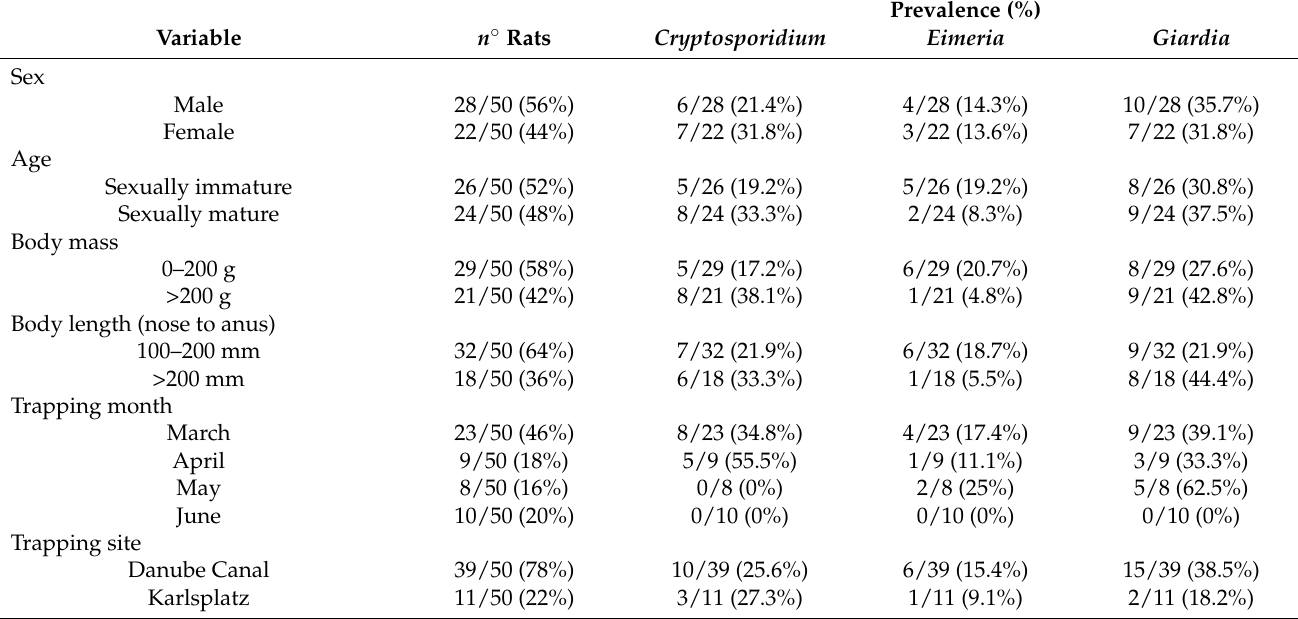
Figure 2. Spatial distribution of the trapped urban brown rats ( R. norvegicus ) at Karlsplatz, April-June 2017, Vienna, Austria. Parasite-positive rats are labeled. Rats trapped were sequentially named AD31–84. Table 1. Prevalence of Cryptosporidium , Eimeria, and Giardia in the faeces of urban brown rats ( R. norvegicus ) calculated according to rat and trapping characteristics.